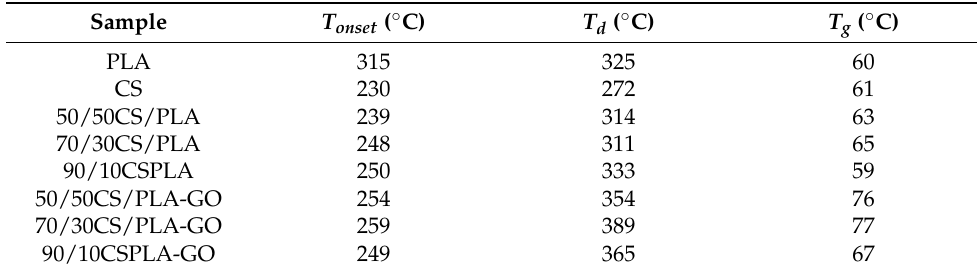
Table 1. Thermal stability analysis.